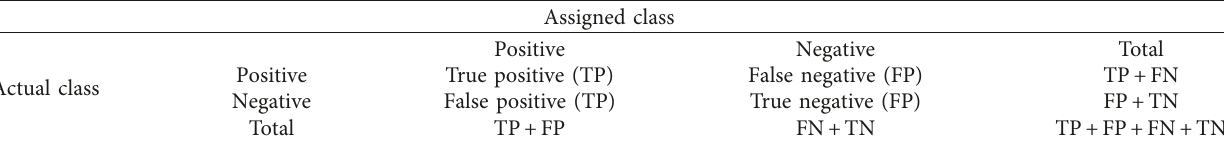
Table 1: Accuracy and